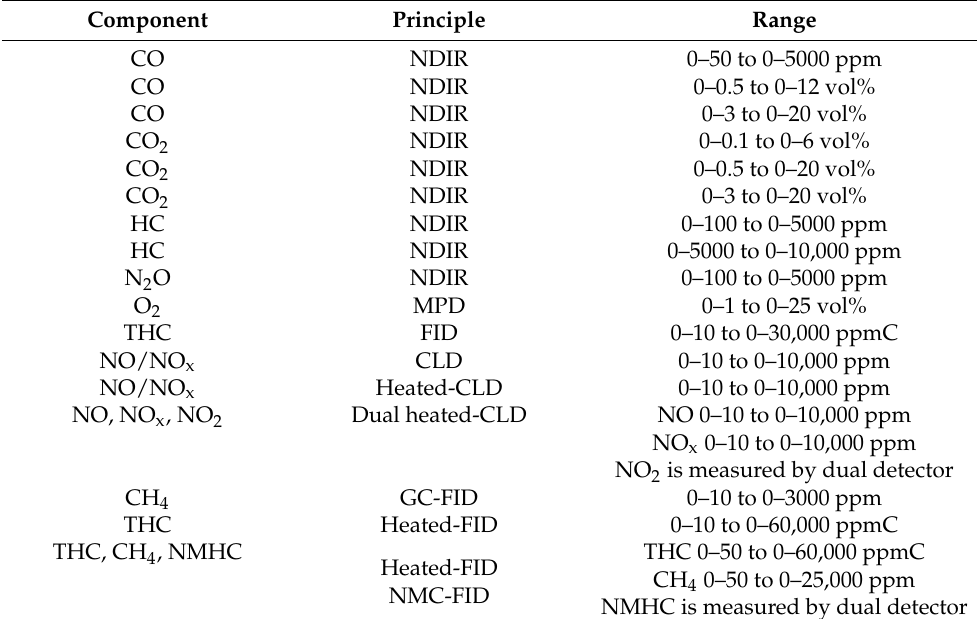
Table A5. Horiba MEXA-ONE Analyzer Specifications (Source: Horiba).